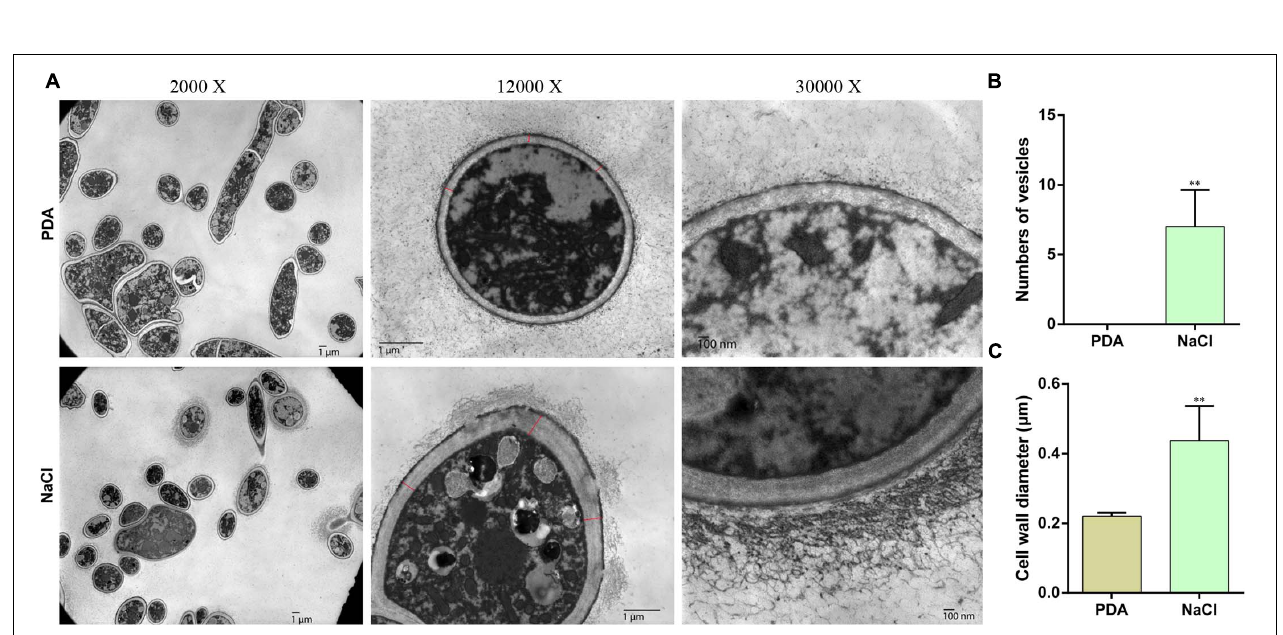
FIGURE 2 | Transmission electron microscopy (TEM) of hyphae of S. turcica cultured on PDA and 0.4 M NaCl. (A) Representative TEM images (magnification, × 2,000, × 12,000, and × 30,000, respectively) of hyphae. (B) The mean number of vesicles in each cell. (C) The mean diameter of the cell wall. Data are presented as the mean ± SD of each cell. ** P <